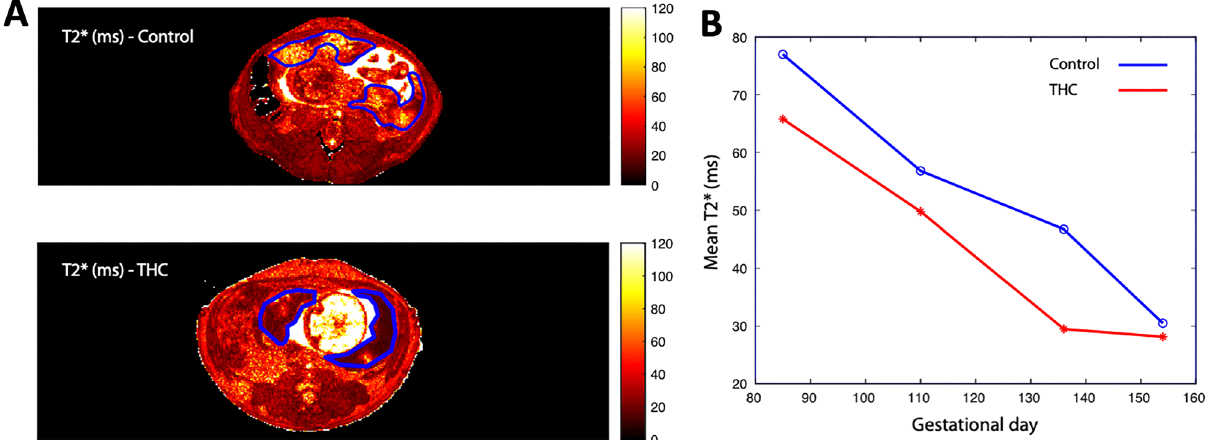
Figure 3. Histogram plot of T 2 * versus percent of placental voxels displayed for THC-exposed (red) vs. control animals (blue) at G85, G110, G135 and G155. ( A ) Quantitative T 2 * maps of placental blood flow of an axial MRI-image at the level of the uterus of a representative control (top) and THC-exposed (bottom) animal with the bi-lobed rhesus macaque placenta outlined in blue. ( B ) THC-exposed animals had a smaller fraction of large T 2 * values compared to controls across all time points, demonstrating decreased placental perfusion and fetal oxygen availability in the former. *p = 0.04 for THC effect by repeated measures ANOVA.